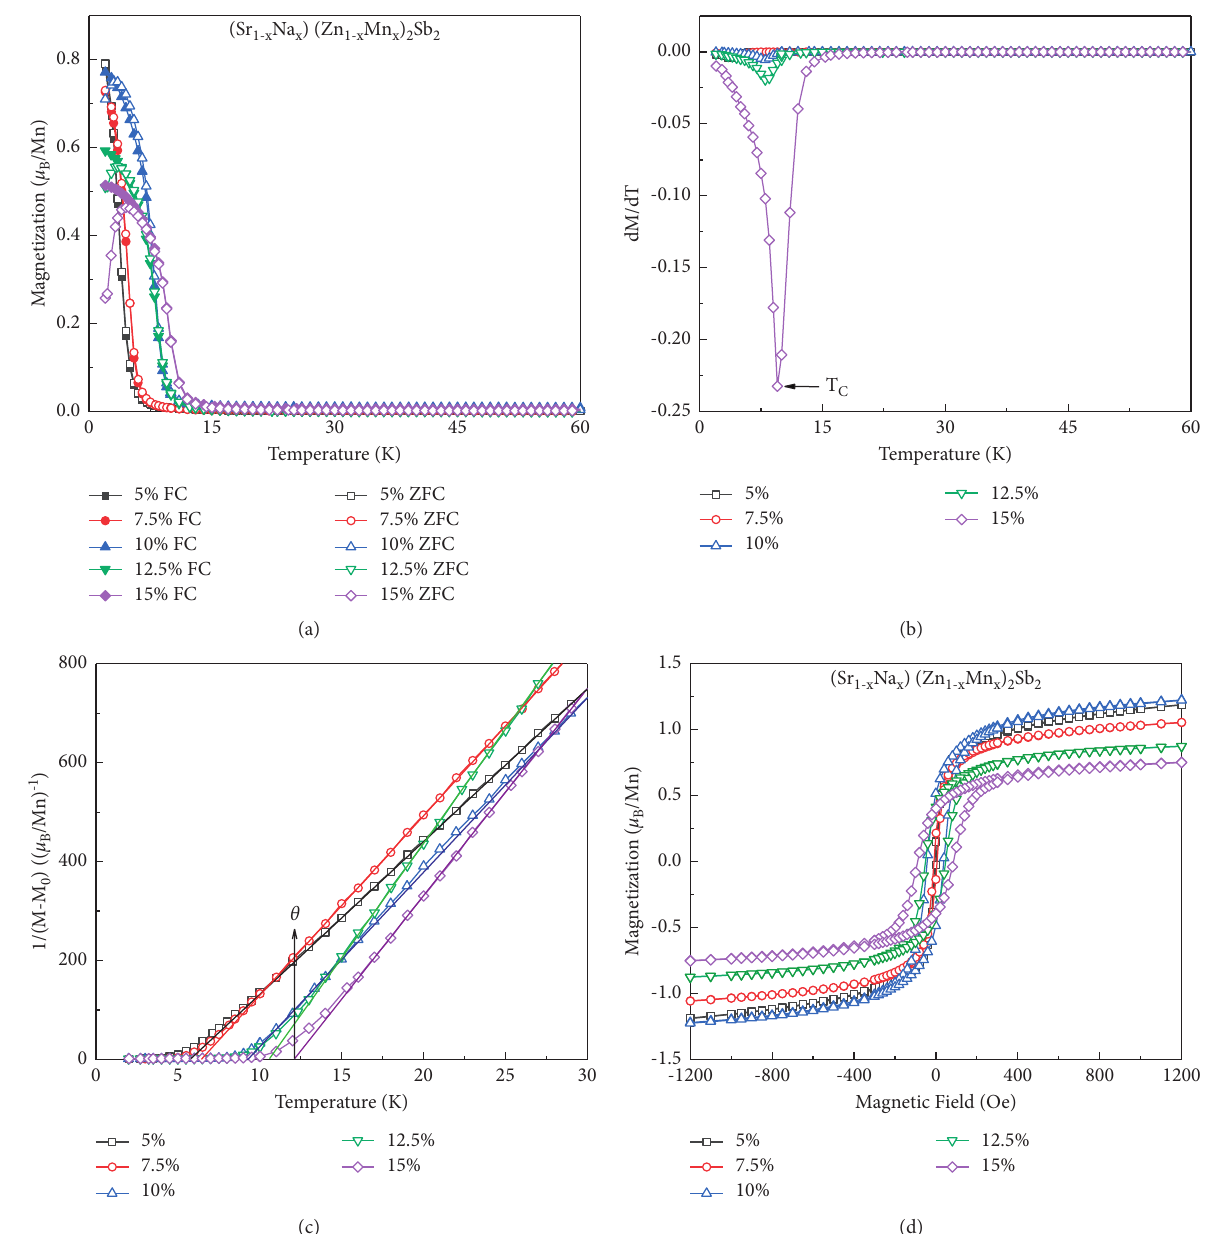
Figure 3: (a) The temperature dependence of magnetization for ( Sr measured under field-cooled and zero-field-cooled conditions with an external field B for ( Sr Na x )( Zn Mn x ) Sb ( x � 0.05, 0.075, 0.10, 0.125, and 0.15). (c) The plot of 1/ ( M − M 1 − x 1 − x 2 2 ( Sr Na x )( Zn Mn x ) Sb ( x � 0.05, 0.075, 0.10, 0.125, and 0.15). (d) Isothermal magnetization for ( Sr 1 − x 1 − x 2 2 0.075, 0.10, 0.125, and 0.15) at 2